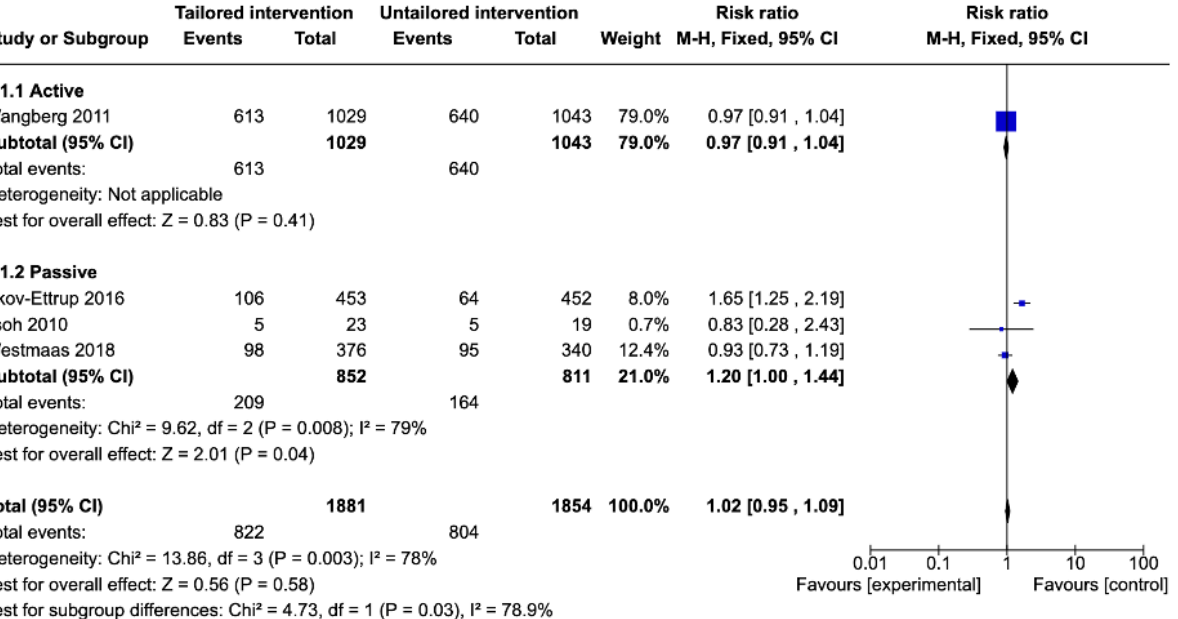
Figure 3. Comparison of attrition between tailored and untailored conditions at 1-month follow-up by control